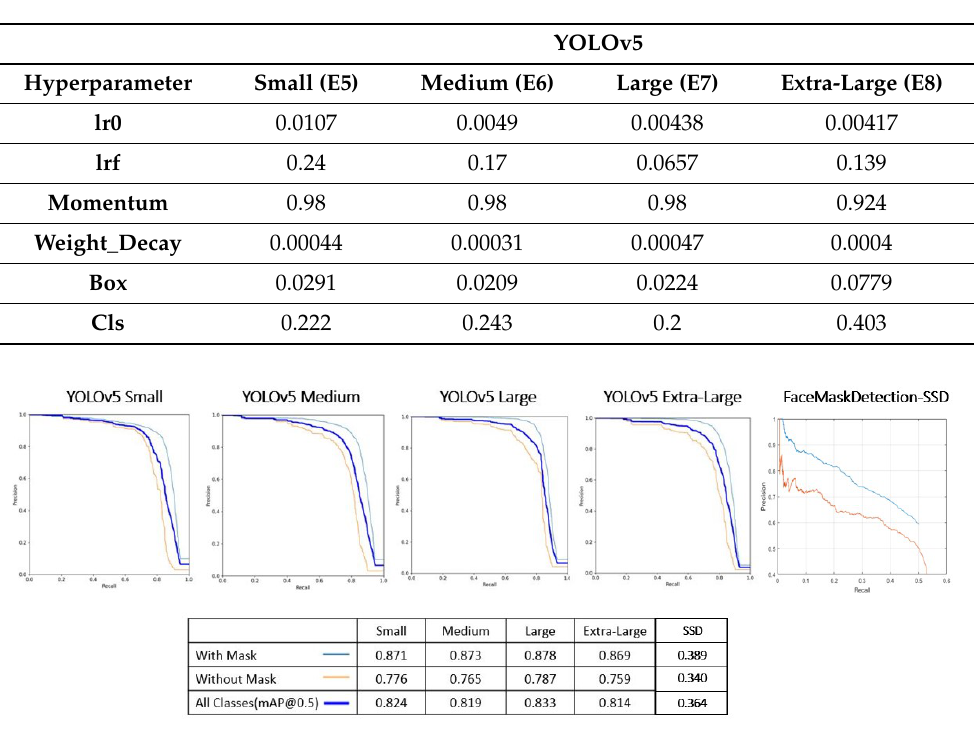
Table 7. Values assigned to main hyperparameters after performing Evolve technique on YOLOv5 models for trials in Table 5.